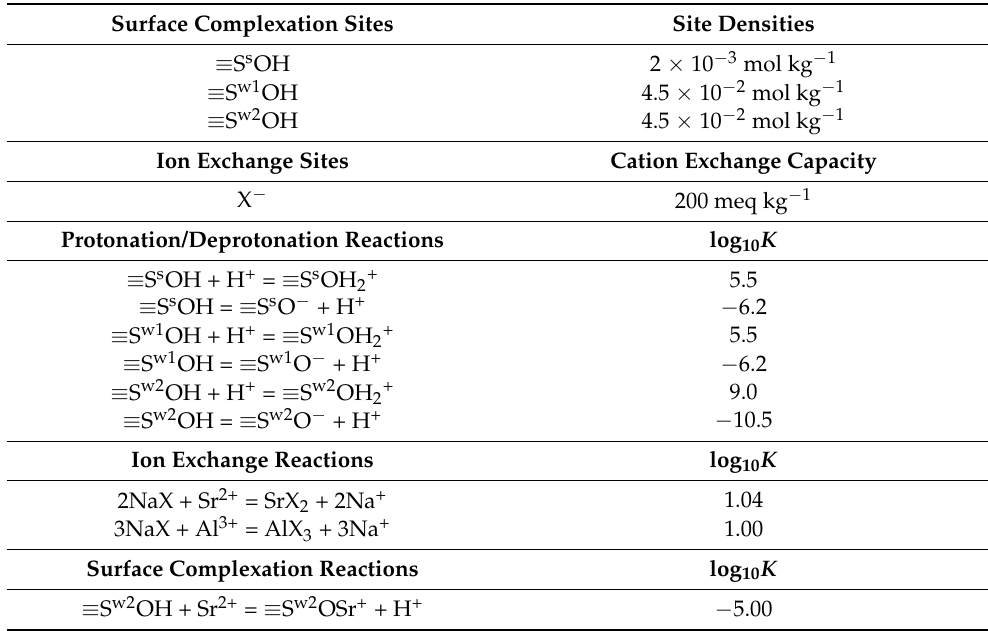
Table 5. The model parameters used for the simulation of the Sr-90 sorption on the polished sample (data from [47]).